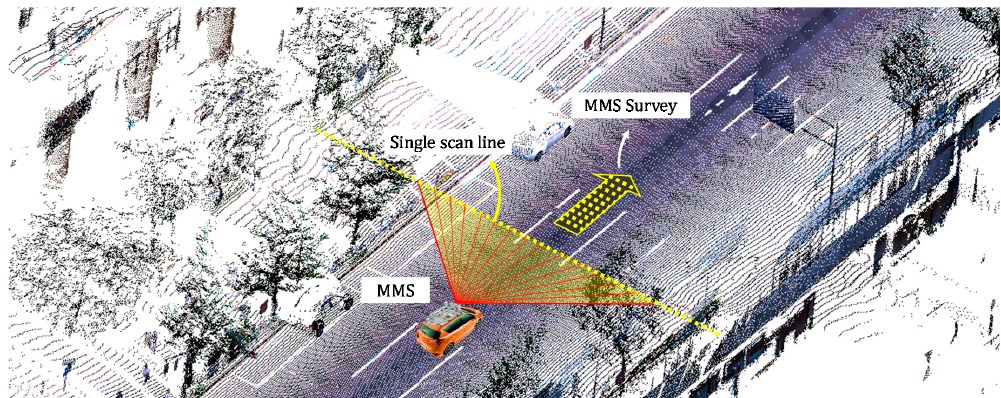
Figure 14. Illustration of single laser scan and MMS survey.